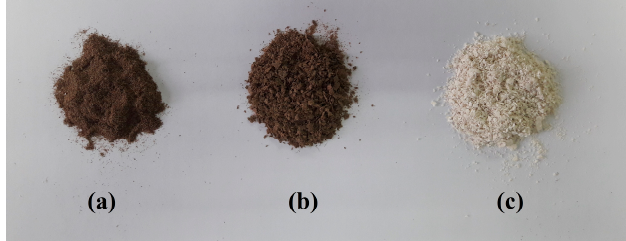
Figure 1. Photographs of ( a ) OPMF, ( b ) alkaline treated OPMF and ( c ) bleached